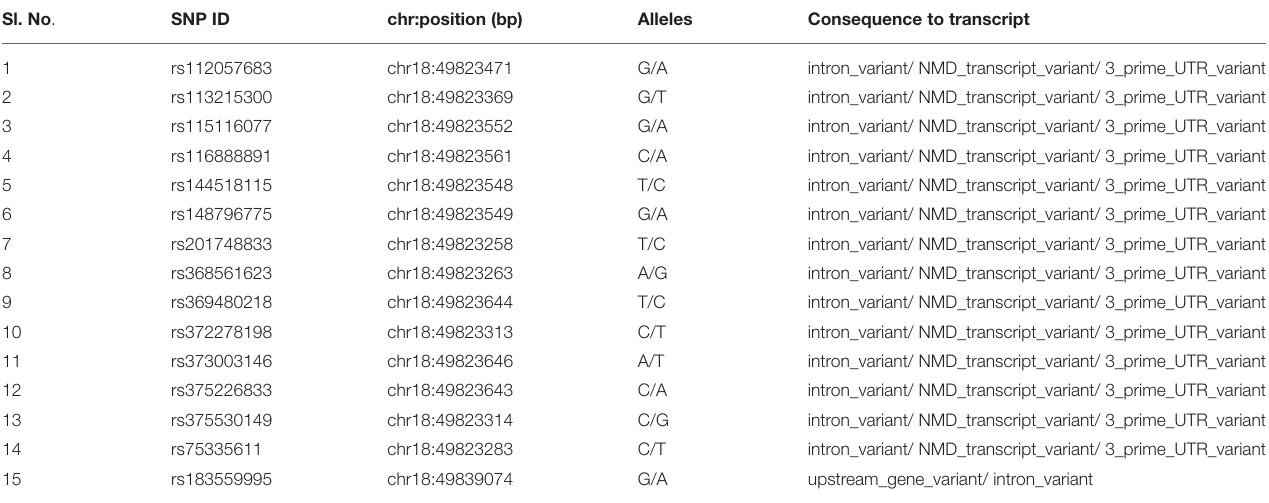
TABLE 2 | List of dbSNPs identified using DNA re-sequencing of MYO5B regions. Sl. No .